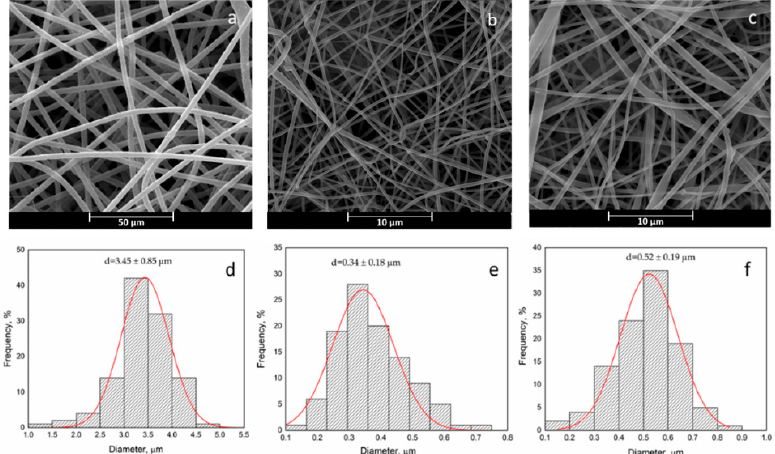
Figure 2. SEM image and fiber diameter distribution: PHB + Curc ( a , d ), PCL + Curc ( b , e ) and PCL/PHB/Curc ( c , f ).